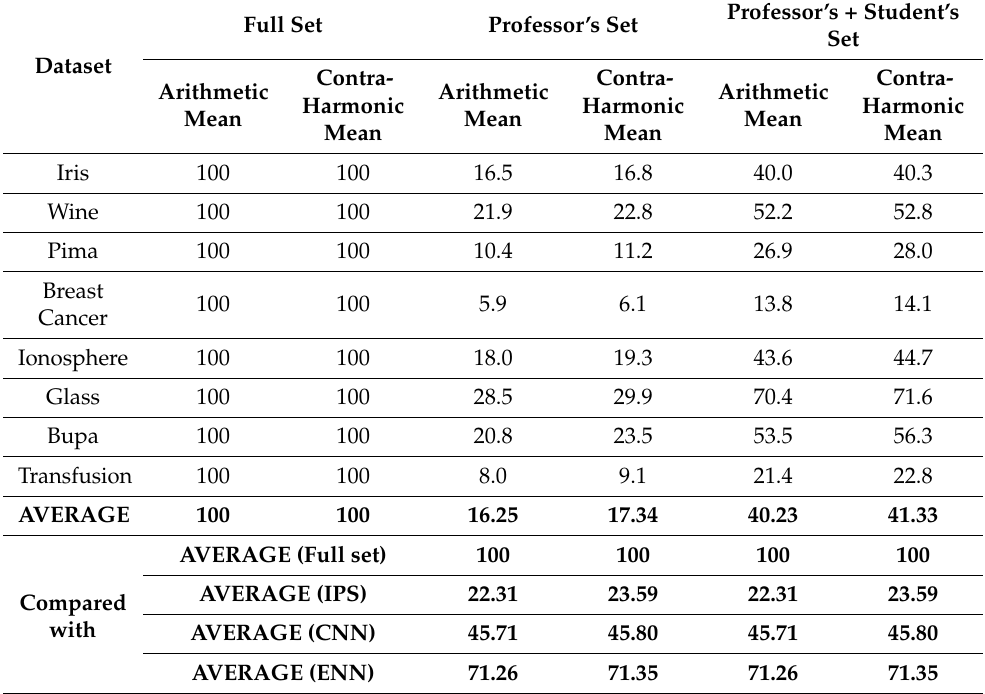
Table 5. Results of the experiments with the Adversarial Prototype Selection (retention rate).